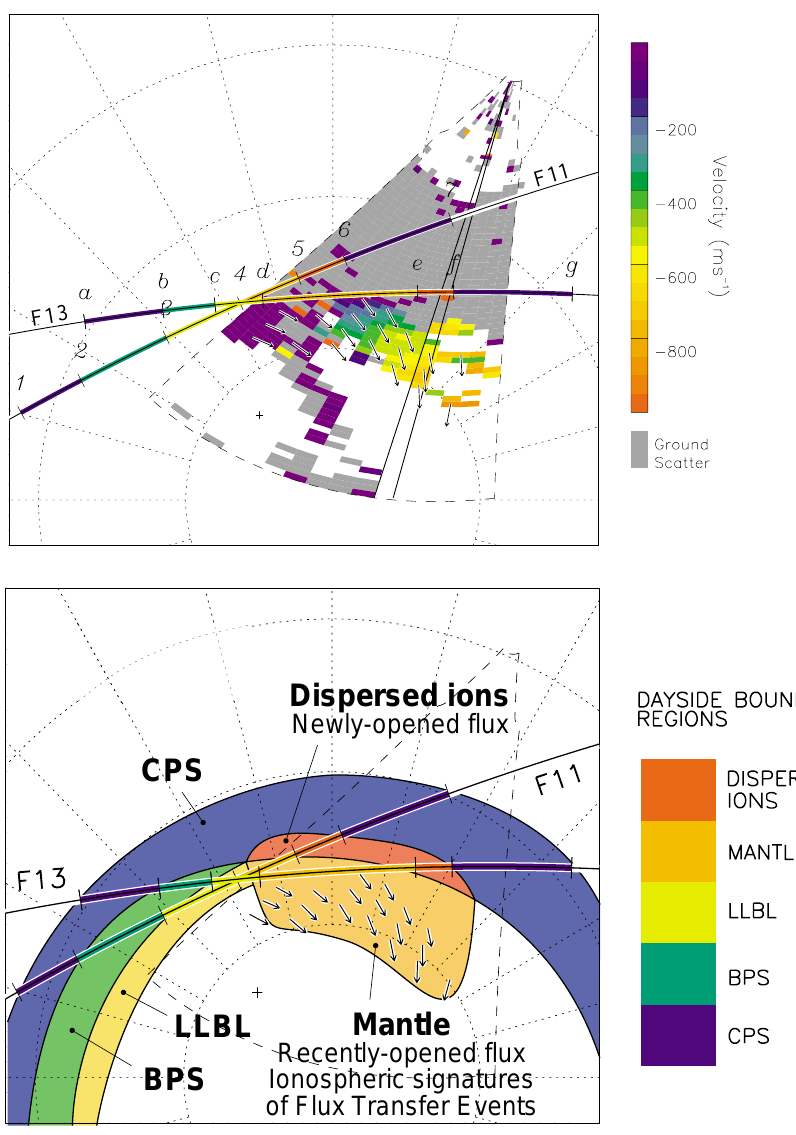
Fig. 3. (a) Polar plot of the l-o-s ve- locity as observed by all the beams of the Hankasalmi radar at 08:04UT. The plot is in a geomagnetic/MLT coordi- nate system, and the radar is pointing towards local noon. Beam 4 is marked with a black line. Beam-swinging vec- tors are overlaid on the plot. Also over- laid are the tracks of the F11 and F13 spacecraft for the time interval shown in Fig. 2. Indicated on the tracks are the dayside boundary regions as defined from the ion and electron spectrograms. (b) A schematic illustration of the re- sults presented in Fig. 3a. The dia- gram presents the tracks of the F11 and F13 spacecraft, and the different day- side boundary regions. The field of view of the Hanksalmi radars and the derived beam-swinging vectors are also shown on the